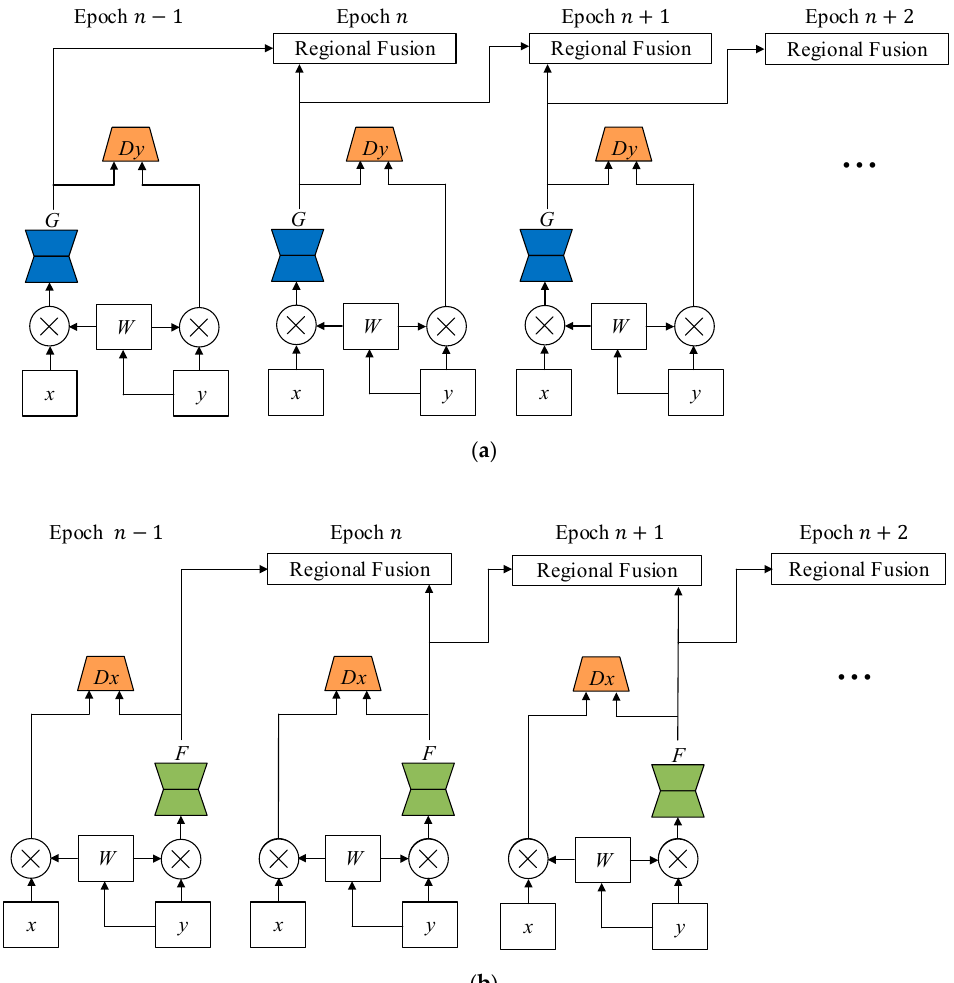
Figure 5. Architecture of the proposed training method: ( a ) generator and ( b ) reconstructor.